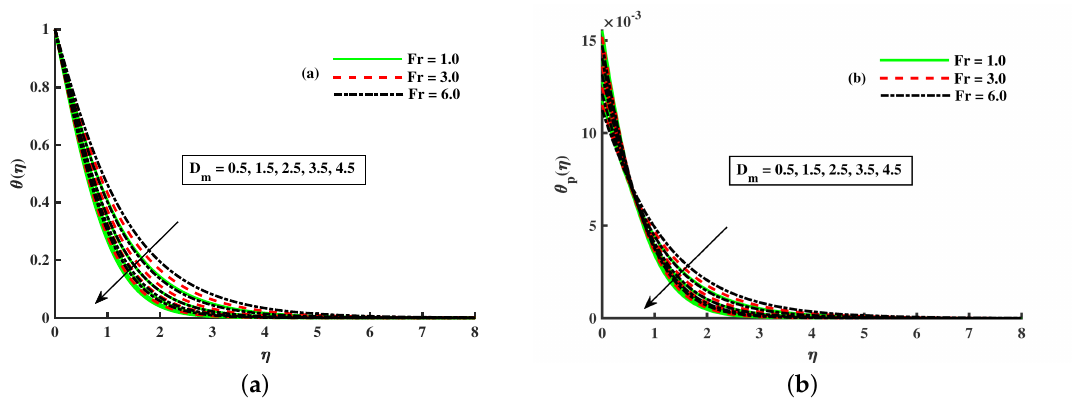
Figure 12. Fluctuation of Fr and D m on G ( η ) ( a ) and the effect of Fr and D m on G p ( η ) ( b ).